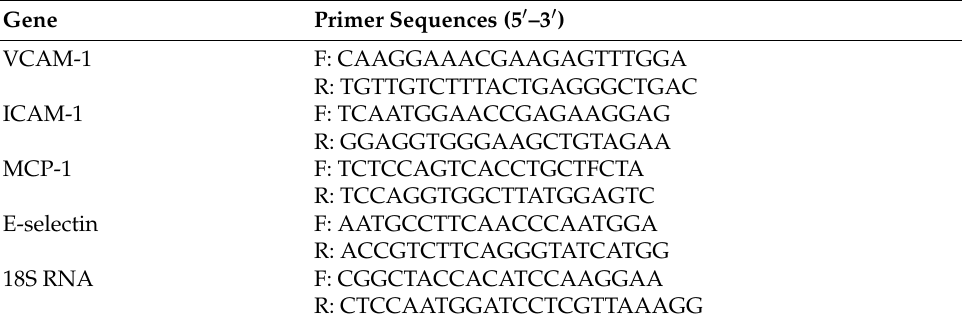
Table 1. Primer sequences for real-time quantitative